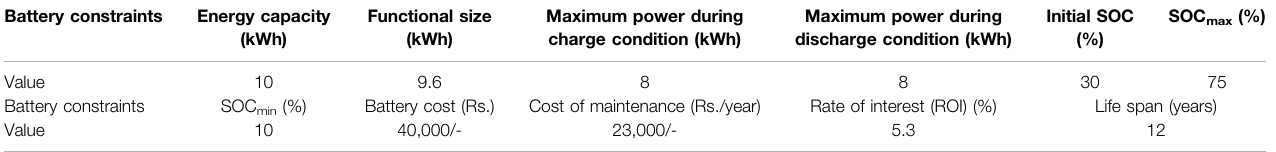
TABLE 1 | Battery speci fi cations.